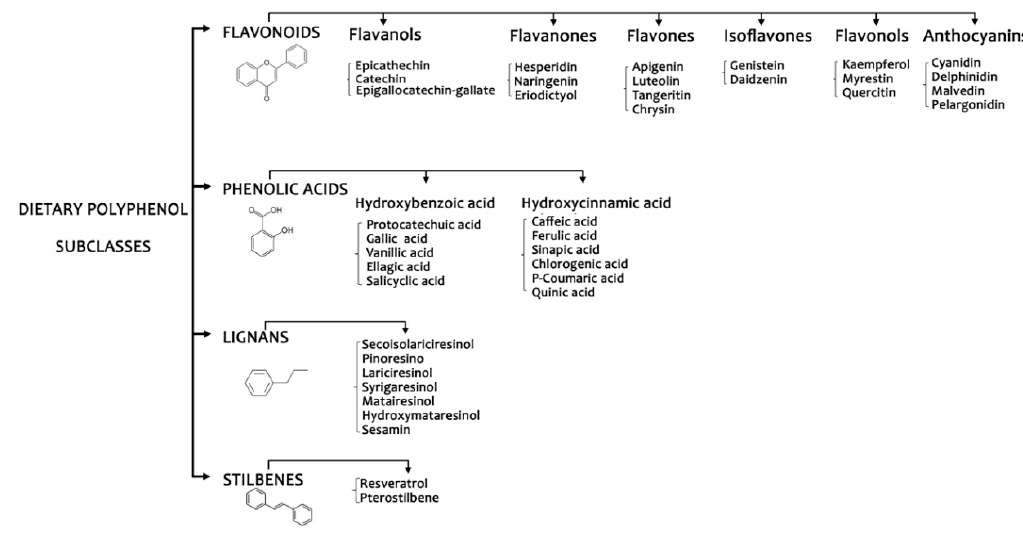
Figure 1. Polyphenol subclasses